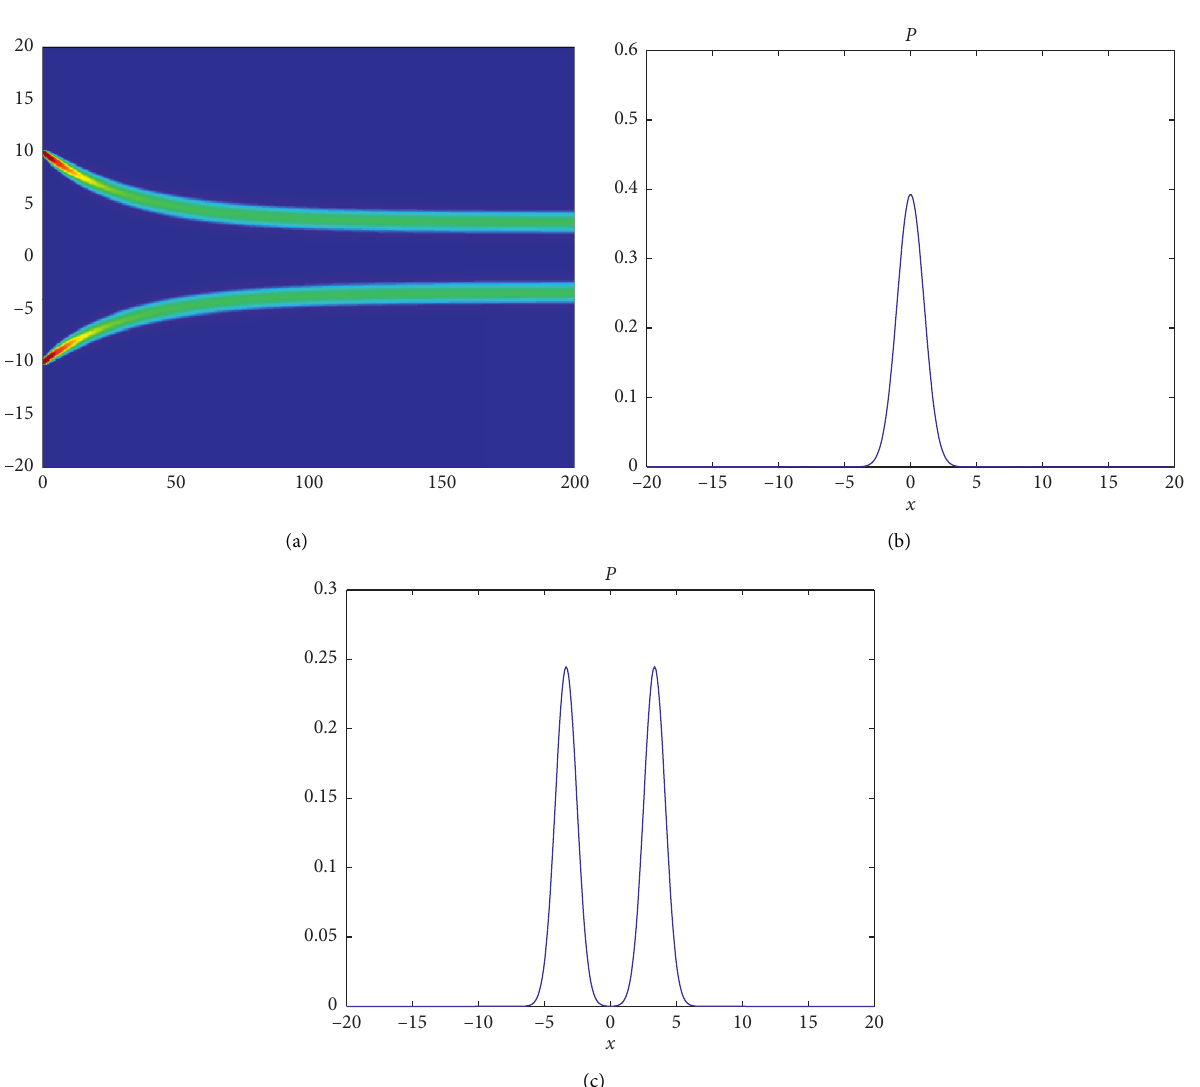
Figure 1: Simulation results. (a) Evolution of the opinion density, with s � 0: 02; a � 0 :02; w � 0: 01. (b) Steady state for the dynamics with parameters s � 0: 02; a � 0: 02; w � 0. (c) Solution profiles at time t � 200, with parameters s � 0:02; a � 0 :02; w �